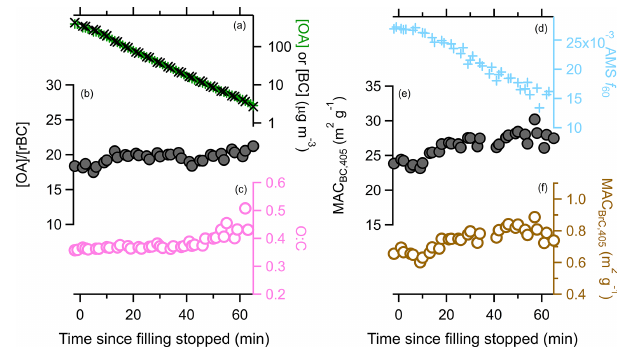
Figure 8. Variation in various particle properties with time during the dark experiment. The change in (a) either the [OA] (green) or [rBC] (black), with [rBC] multiplied by 20; (b) the [ OA ] / [ rBC ] ratio; (c) the O:C ratio (circles) or OA mass fraction remain- ing (triangles); (d) the AMS f 60 biomass burning marker; (e) the MAC BC , 405nm ; and (f) the MAC BrC , 405nm